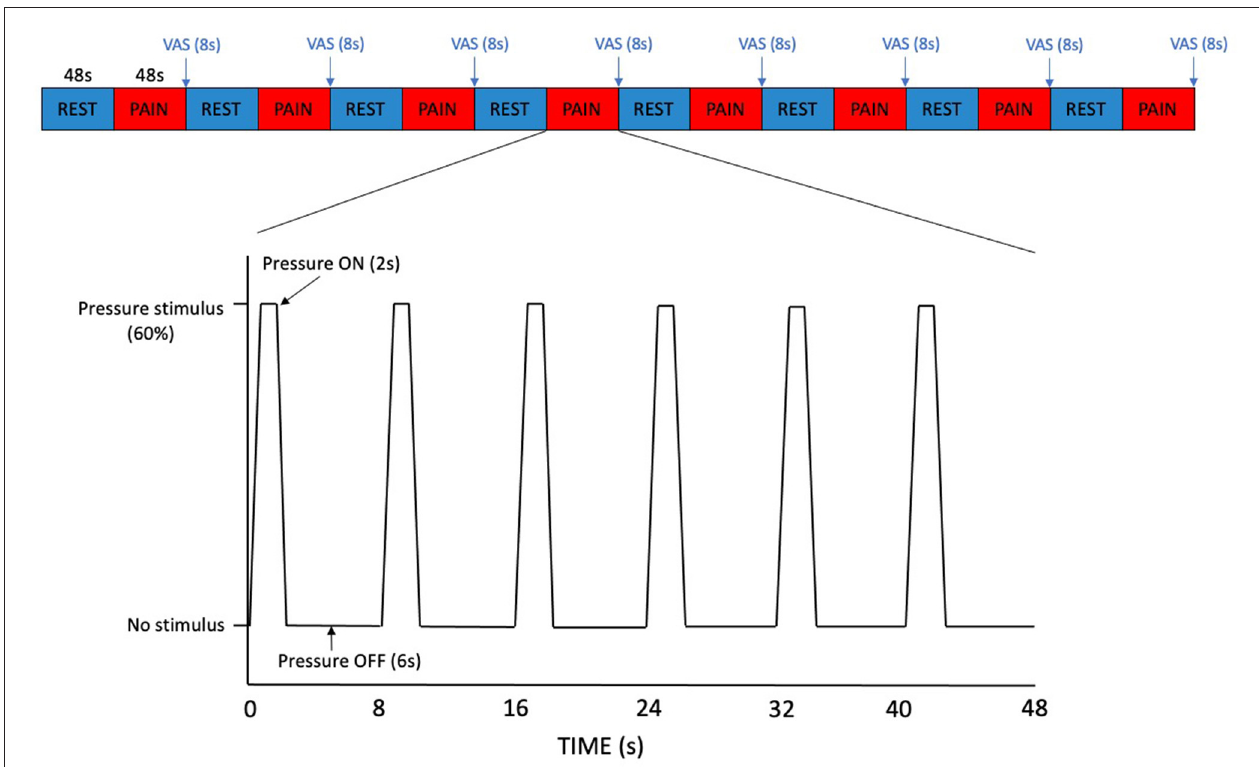
FIGURE 1 | Pressure pain paradigm. Each block of REST and PAIN was 48s in duration. In the PAIN blocks, each pressure stimulus had a duration of 2s, separated by a 6s interval. A VAS pain scale was displayed for 8s at the end of each PAIN block.